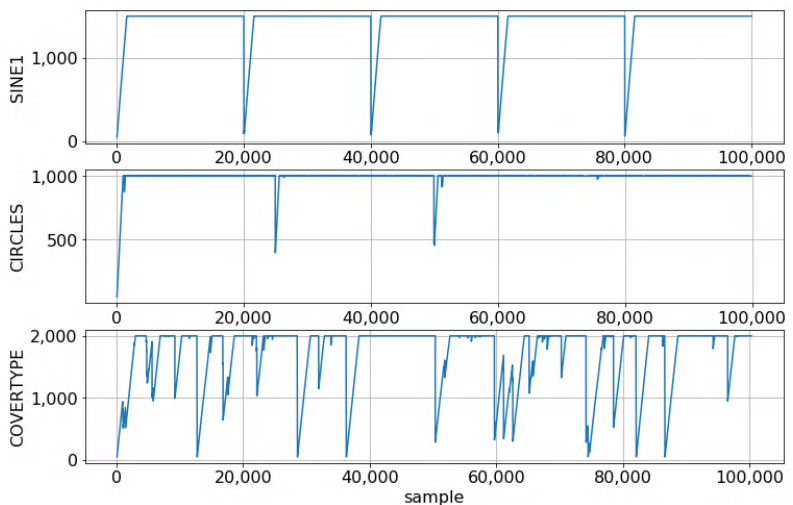
Figure 3. Dynamic window sizes for the considered